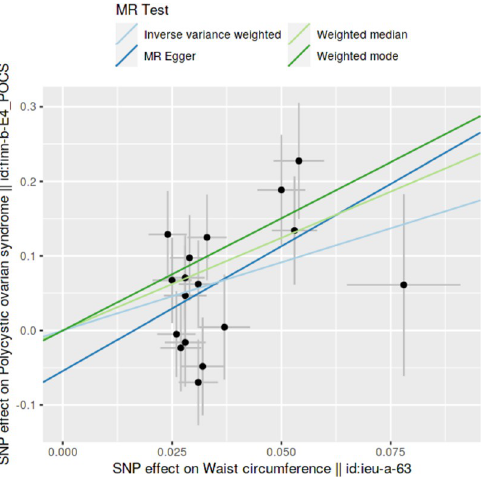
Fig 3. Scatter plot illustrating the distribution of individual ratio estimates of waist circumference with polycystic ovarian syndrome as the outcome. Trend lines from the four different two-sample Mendelian randomization methods employed indicating the positive causal associations, are also included in each scatter